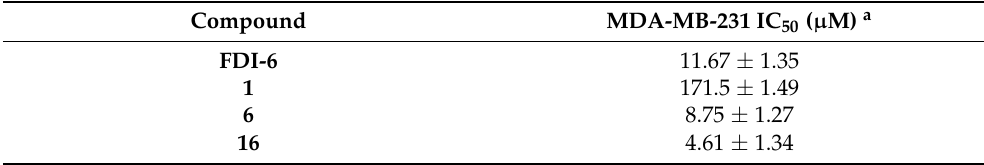
Table 1. IC 50 values determined for test molecules FDI-6 , 1 , 6 , and 16 using the human breast cancer cell line